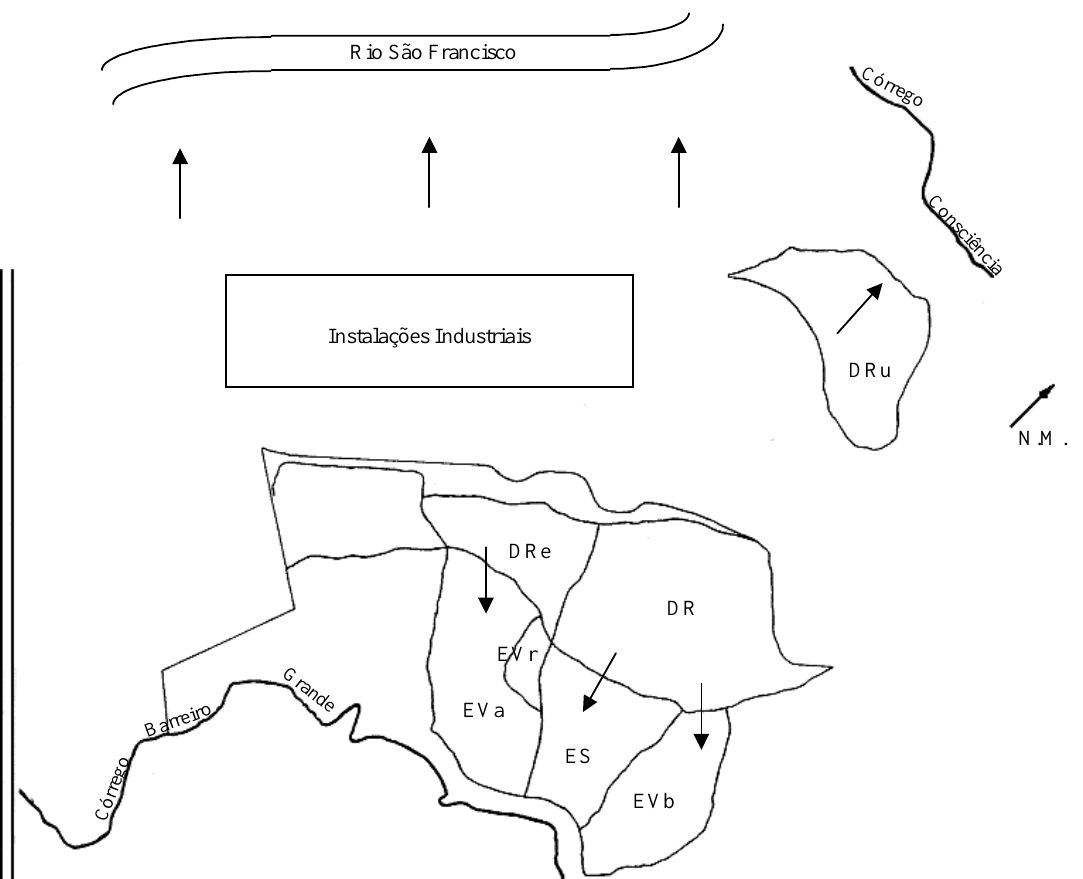
Figura 1. Croqui da área em estudo com os locais estudados. Setas indicam o sentido da declividade do terreno, que varia de 4 a 8% nos locais amostrados. DR-área de deposição sem vegetação; DRe-área de deposição plantada com eucalipto; ES-área sob influência de escoamento sem vegetação; EVa- área com vegetação de cerrado arbóreo-arbustivo sem vegetação rasteira; EVr-área com vegetação de cerrado arbóreo-arbustivo com vegetação graminóide; EVb-área com Brachiaria ; DRu-área de deposição dos resíduos da